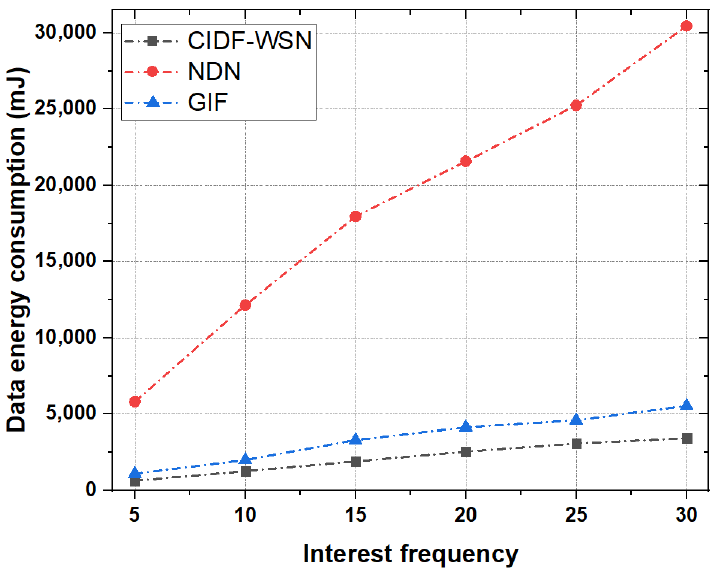
Figure 11. Data energy consumption as a function of